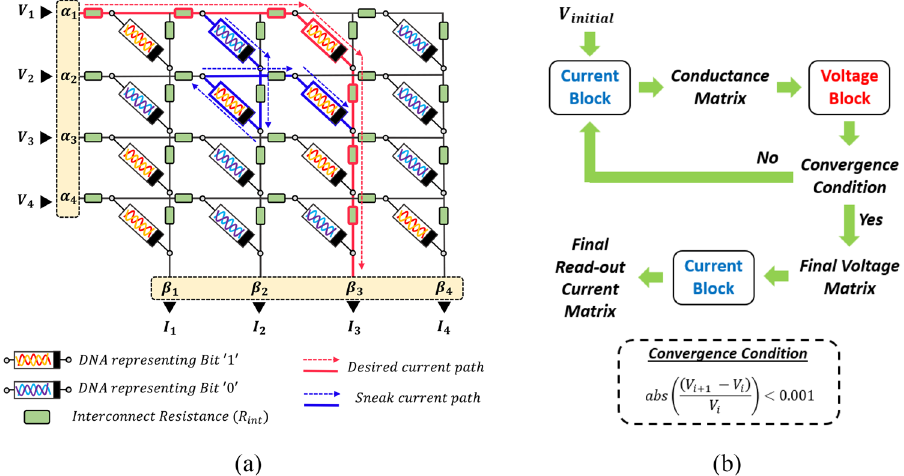
Figure 3. ( a ) Circuit schematic of a 4 × 4 array, where α i and β j are array size dependent scaling factors which account for the interplay between interconnect resistance and sneak paths. ( b ) Flow chart for crossbar simulation. ‘Voltage Block’ comprises of the set of equations governing the voltage distribution in the crossbar (see Eq. 10) while ‘Current Block’ is a look-up-table created with the DNA currents ( I DNA ) obtained from DNA current simulations (see Eq.